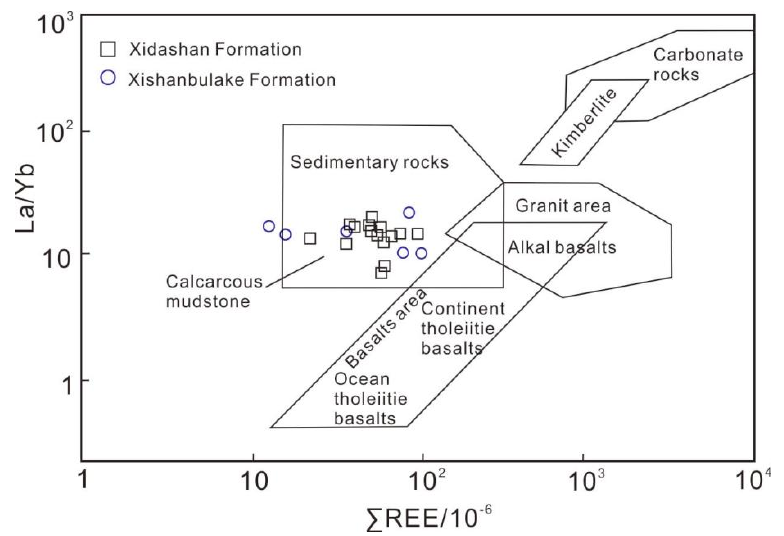
Figure 6. ∑ REE vs. La/Yb diagram of the Lower Cambrian mudstone (modified from Xie et al., 2018 [6]).